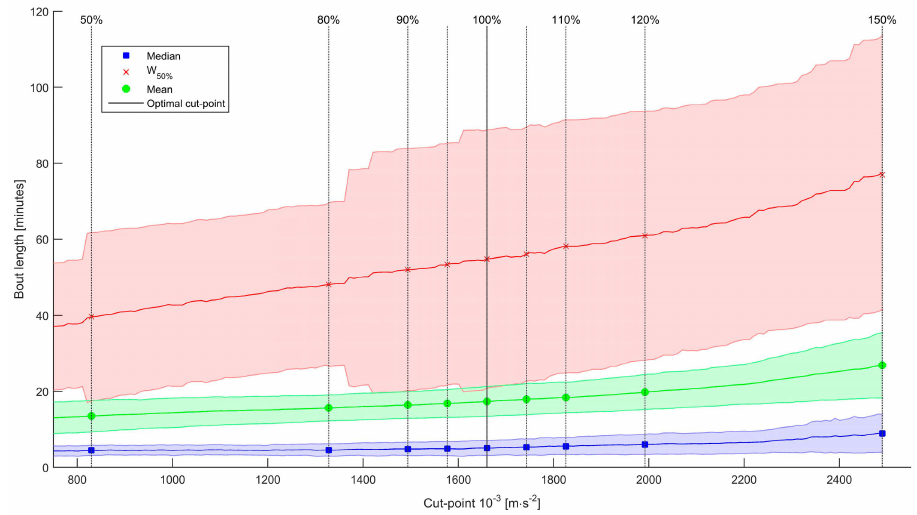
Figure 4. Bout length variables for various cut-points. Blue: Median bout length; green: Mean bout length; red: W 50% bout length. Shaded areas are the standard